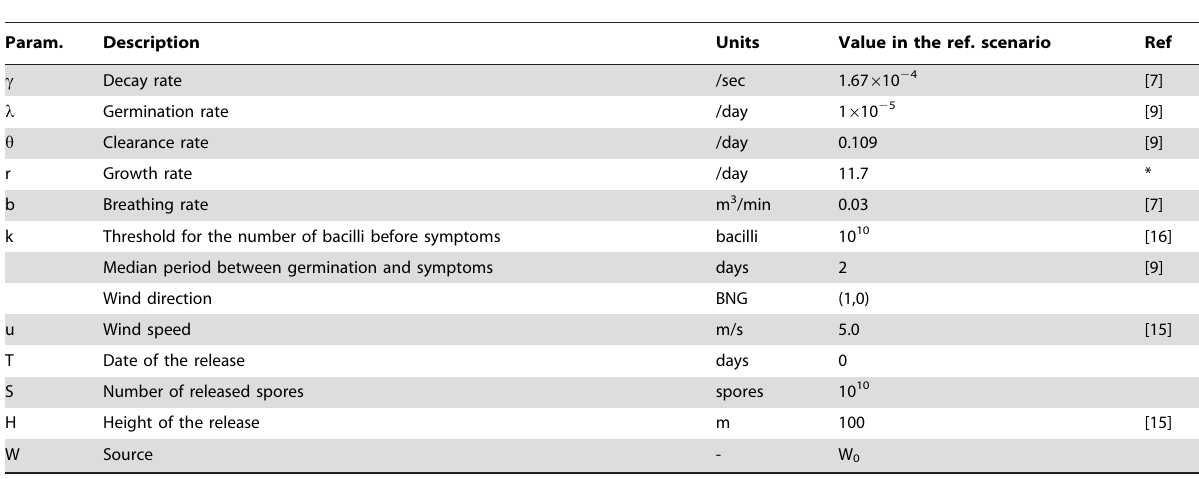
Table 1. Parameter Description and Values in the Reference Scenario.